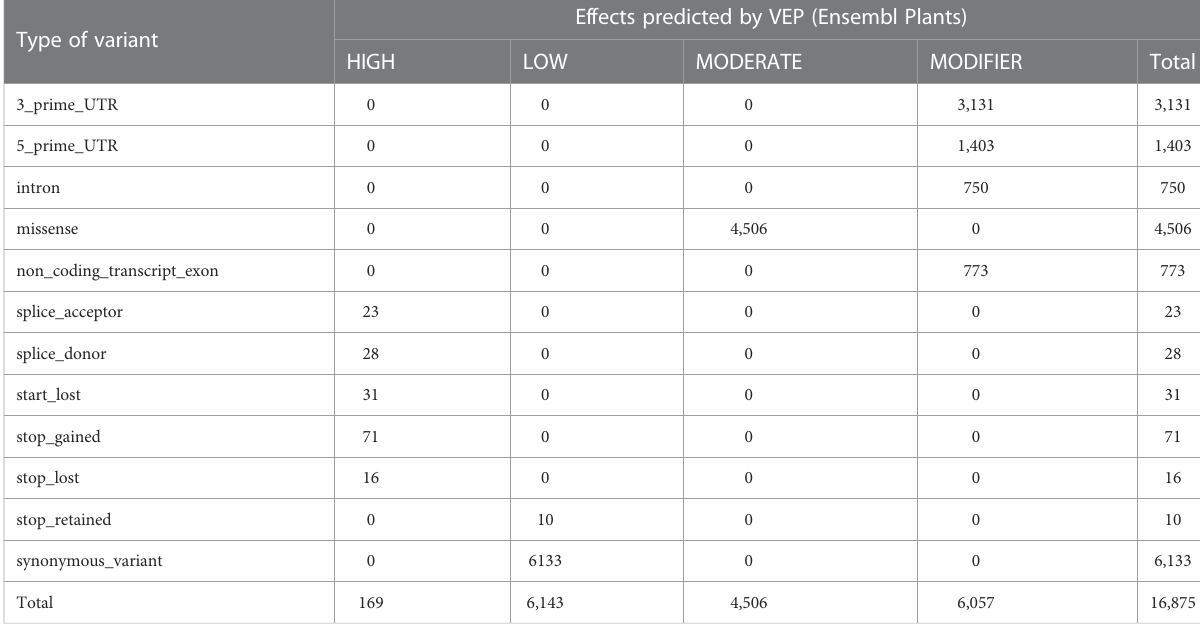
Effects predicted by VEP (Ensembl